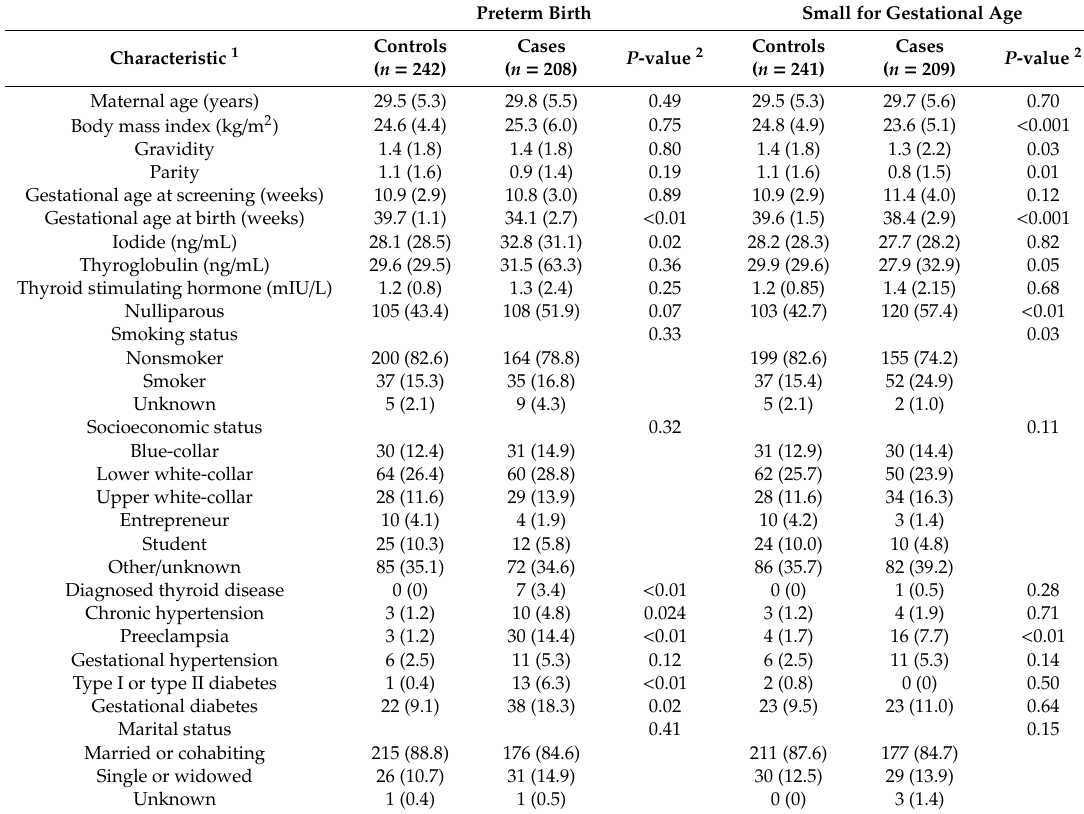
Table 1. Maternal characteristics at blood draw according to preterm birth and small for gestational age cases and controls in the Finnish Maternity Cohort and Medical Birth Register,